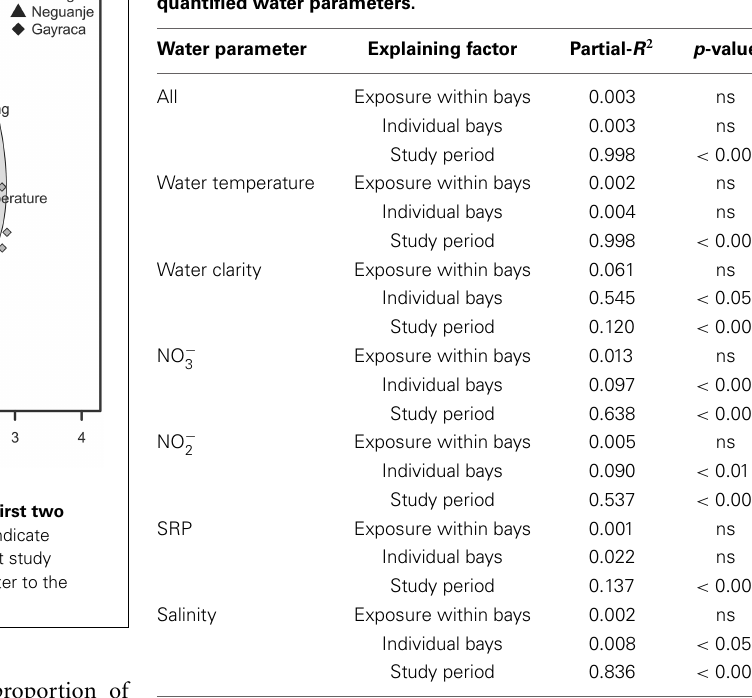
Table 2 | Results of repeated-measure mixed-models testing the influence of study period, exposure within bays, and bay on quantified water